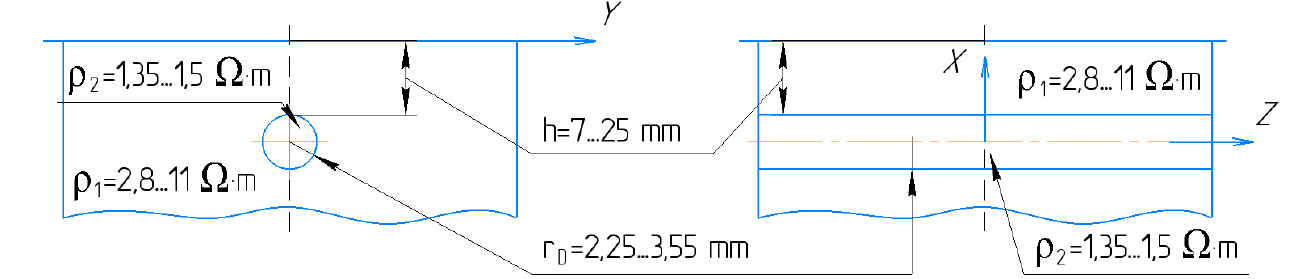
Figure 3. The mathematical model of artery in the region of interest.